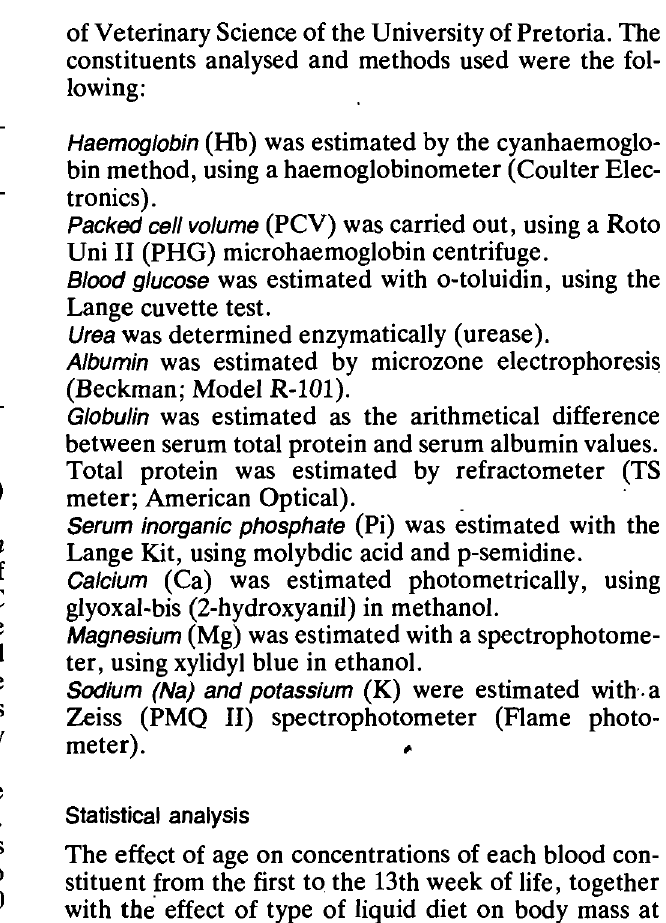
Table 2: COMPOSITION AND ANALYSIS OF